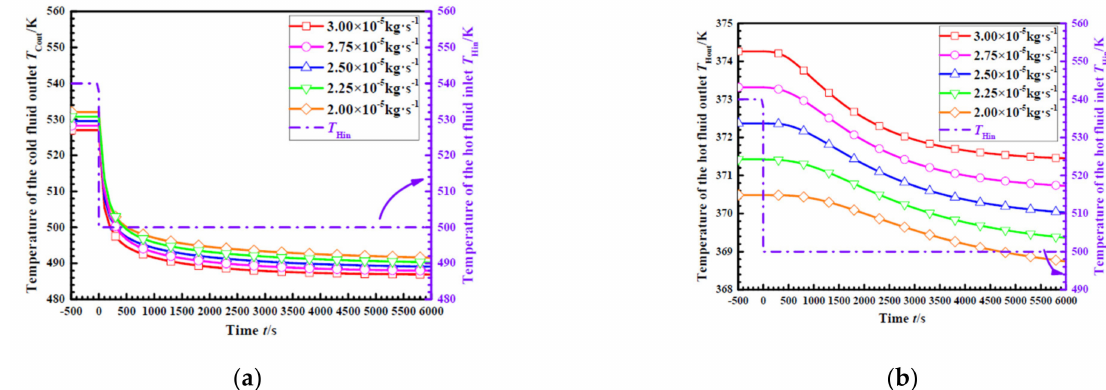
Figure 6. The comparison of the temperature disturbance. ( a ) Temperature of the cold fluid outlet. ( b ) Temperature of the hot fluid